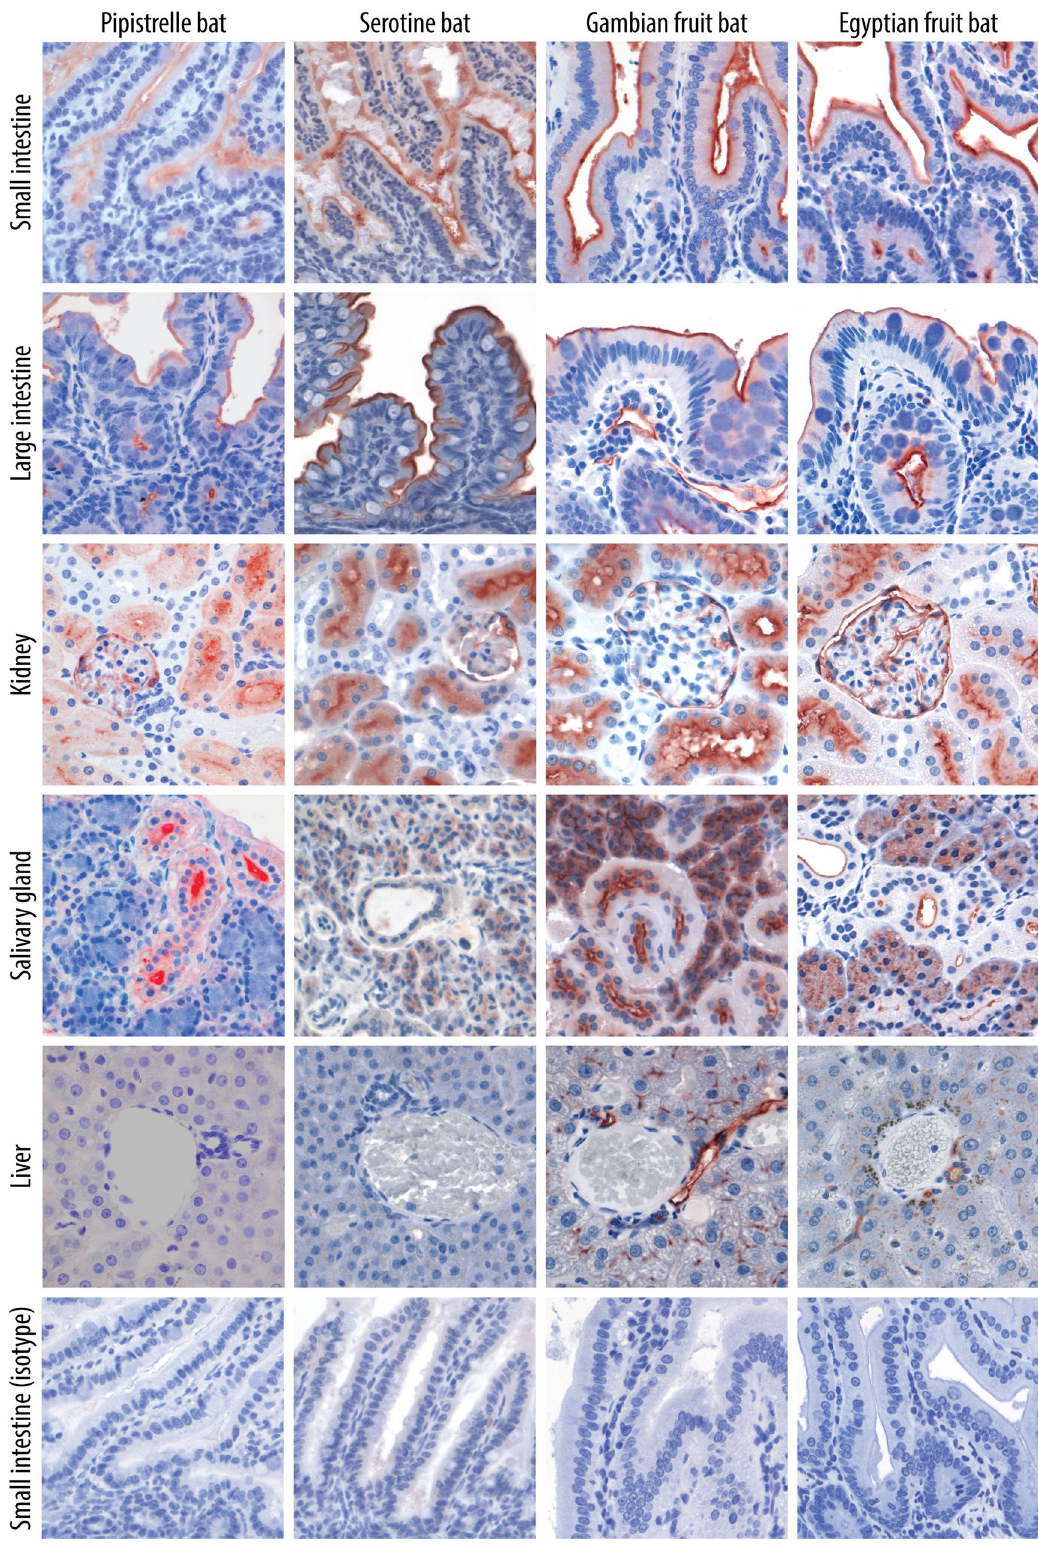
Figure 2. DPP4 expression in the intestine, kidney, salivary gland, and liver tissues of the common pipistrelle bat, serotine bat, Gambian epauletted fruit bat, and Egyptian fruit bat. In all four bat species, DPP4 (indicated in red) is detected on the apical surface of the intestinal epithelium, proximal tubular epithelium of the kidney, and in the salivary glands. Normal goat serum is used as isotype control for each tissue and showed no background signal. Only isotype control staining of the small intestines is shown. Original magnification x400 for all